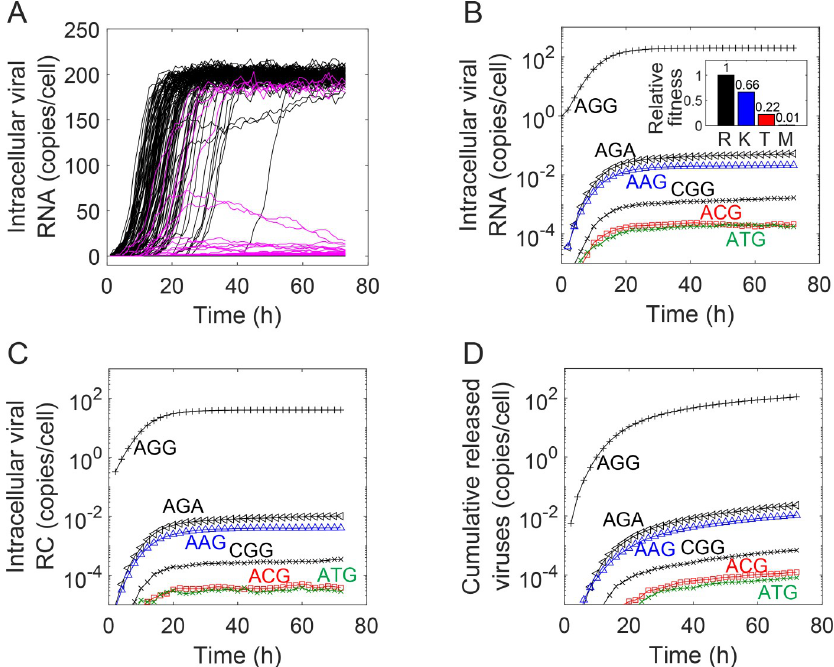
Fig 2. Intracellular dynamics and evolution. (A) Time-evolution of the populations of wild-type (black) and single mutant (pink) RNA genomes in infected cells. Infection is initiated by the wild-type. Each trajectory is a realization. The three patterns where the wild-type dominates, the mutant dominates, and where the mutant rises initially but is eventually outcompeted are illustrated. (B) The averaged evolution of the populations of genomes carrying different codons following infection with AGG. The relative fitness of the genomes, determined independently [19], is in the inset and is color coded. (C), (D) The corresponding populations of replication complexes and virions released.